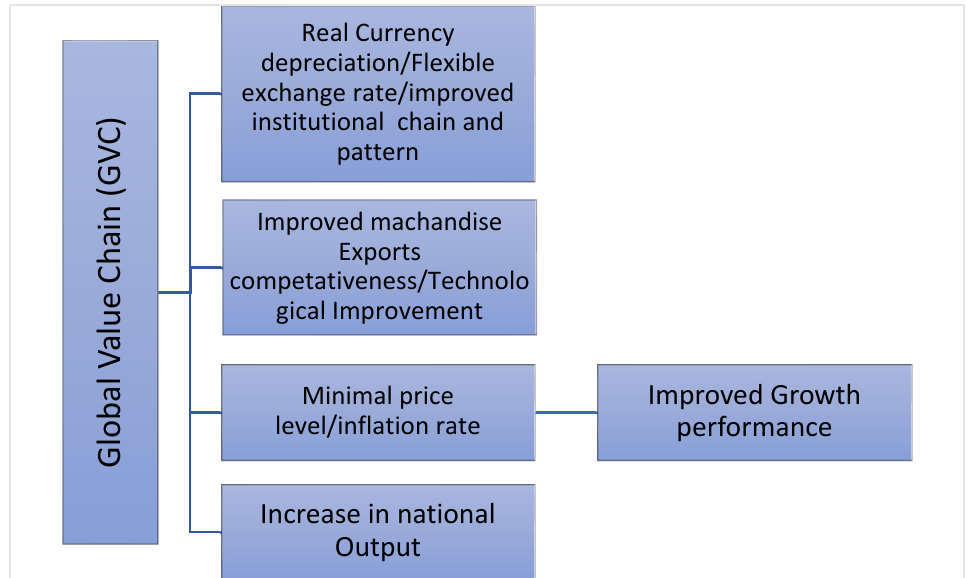
Figure 1. Schematic Framework for Valued exchange rate, Price level, and Growth Performance Relationship. Source: Authors .